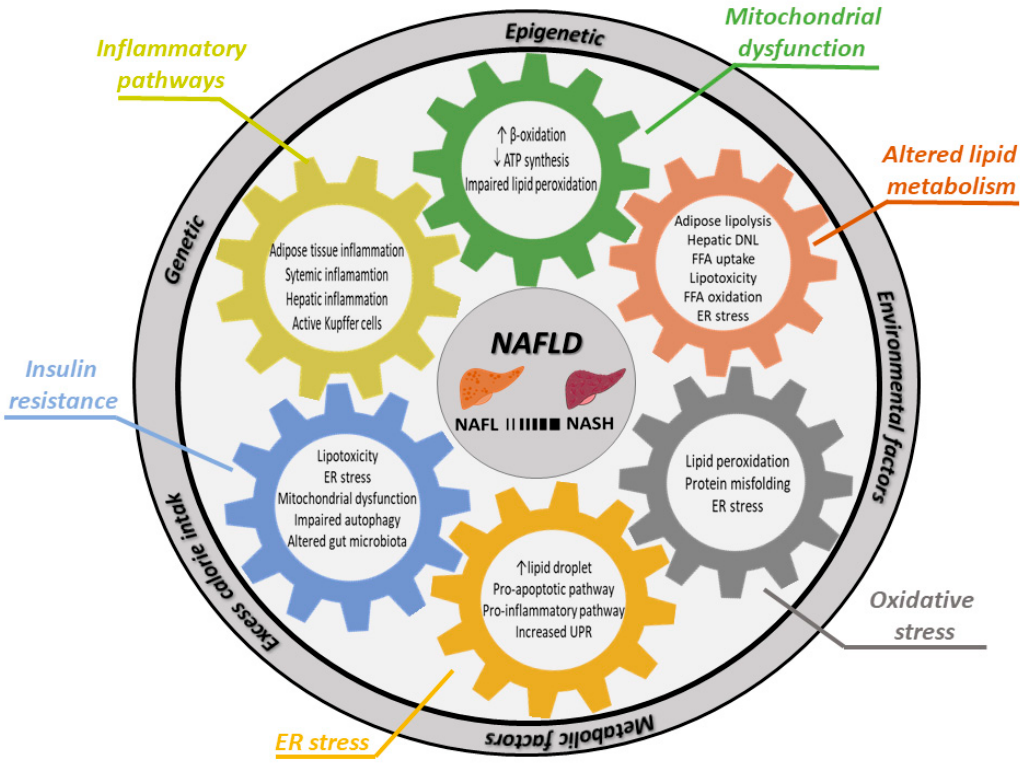
Figure 1. Factors contributing to development of NASH or progression of NAFL to NASH. NAFLD develops due to excess calorie intake, which leads to adipose tissue hypertrophy. Adipose tissue confronted with nutrient overload will increase lipolysis and change secretion of adipokines. This altered systemic situation of nutrients, lipids and adipokines, ultimately resulting in NAFLD, is modulated by genetic, epigenetic, environmental and metabolic factors (outer ring). Various molecular and cellular mechanisms (cogs) interact in development of NAFLD and NASH.